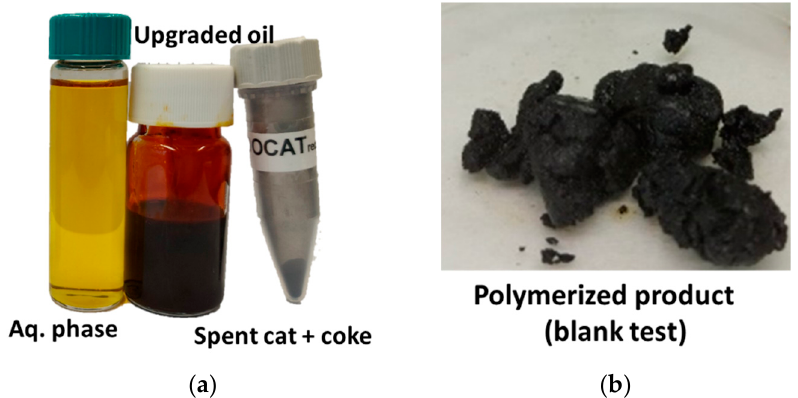
Figure 4. ( a ) Upgraded products obtained during the HDO with an active catalyst: upgraded oil, aqueous phase and recovered catalyst together with solid phase. ( b ) Polymerized product obtained in the absence of an active catalyst.